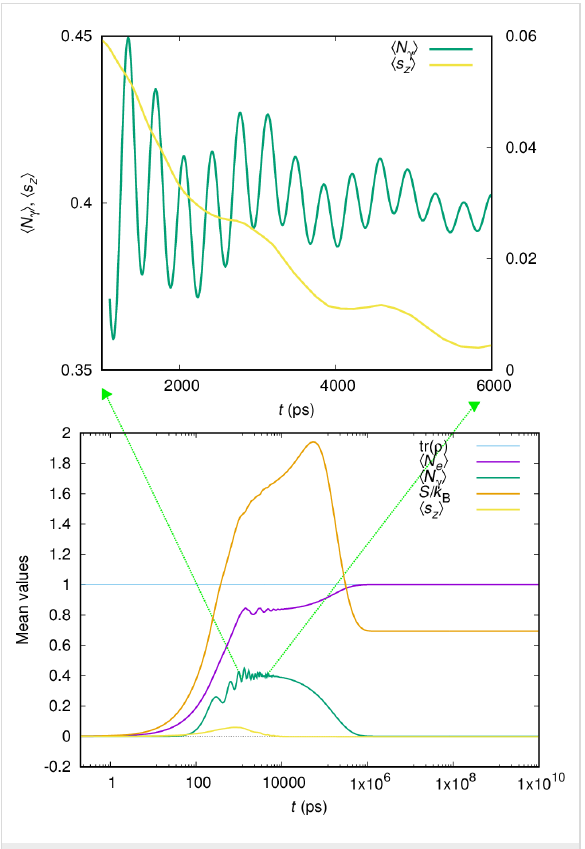
Figure 4: The mean electron and photon content in the open central system as a function of time. In addition, the mean z -com- ponent of the total spin, trace of the reduced density matrix, and the entropy of the open central system S / k B are shown. The upper panel shows the details of (left y -scale) and (right y -scale) for the intermediate time range. = 0.343 meV, κ = 1.0 × 10 − 5 meV, B ext = 0.1 T, g EM = 0.05 meV, = 0, and x -polarized cavity photon.